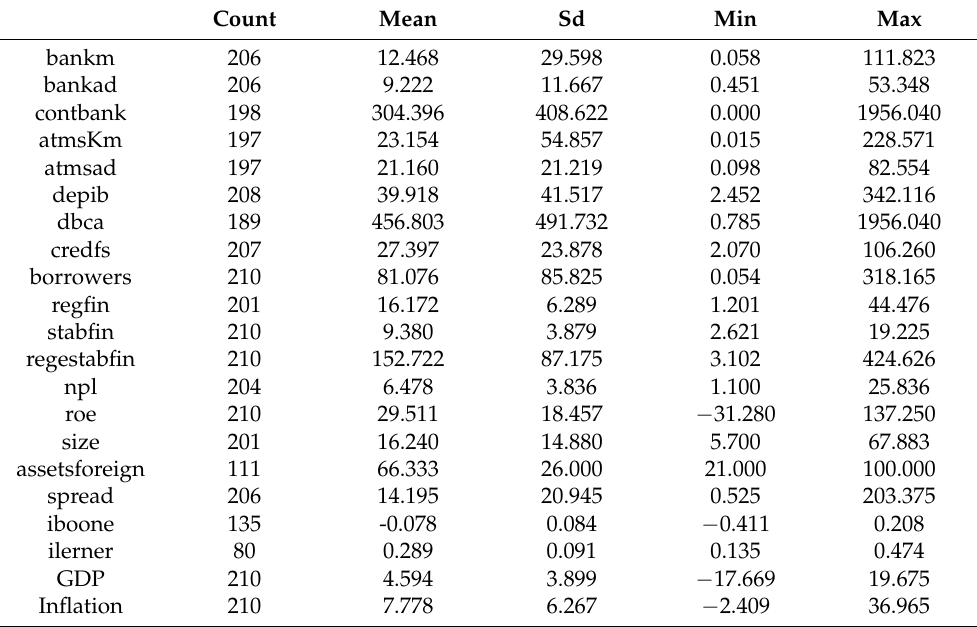
Table 2. Descriptive statistics for SADC (Southern Africa Development Community)